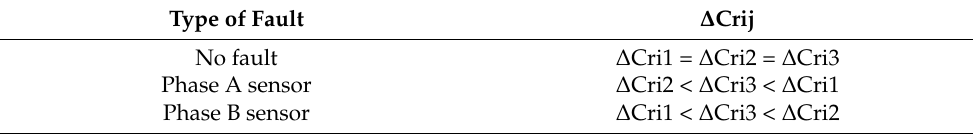
Table 3. Dependencies between marker errors during failure in particular